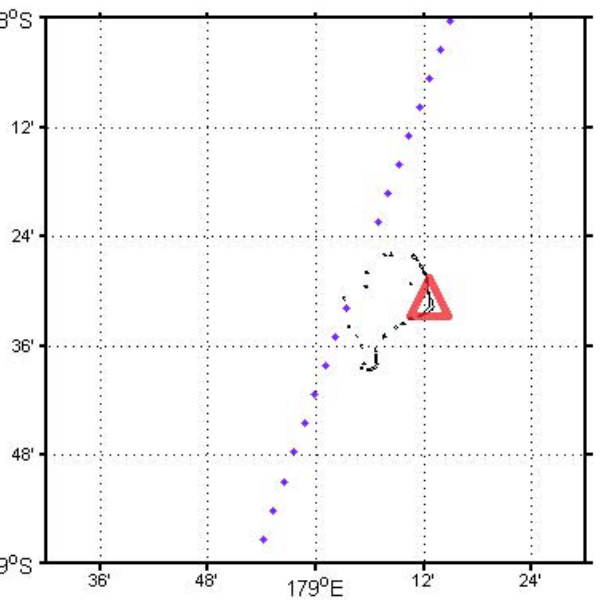
Fig. 3. The root-mean-square error of tide gauge and altimeter data for 19 years (March 1993 to July 2012) reaches a value of